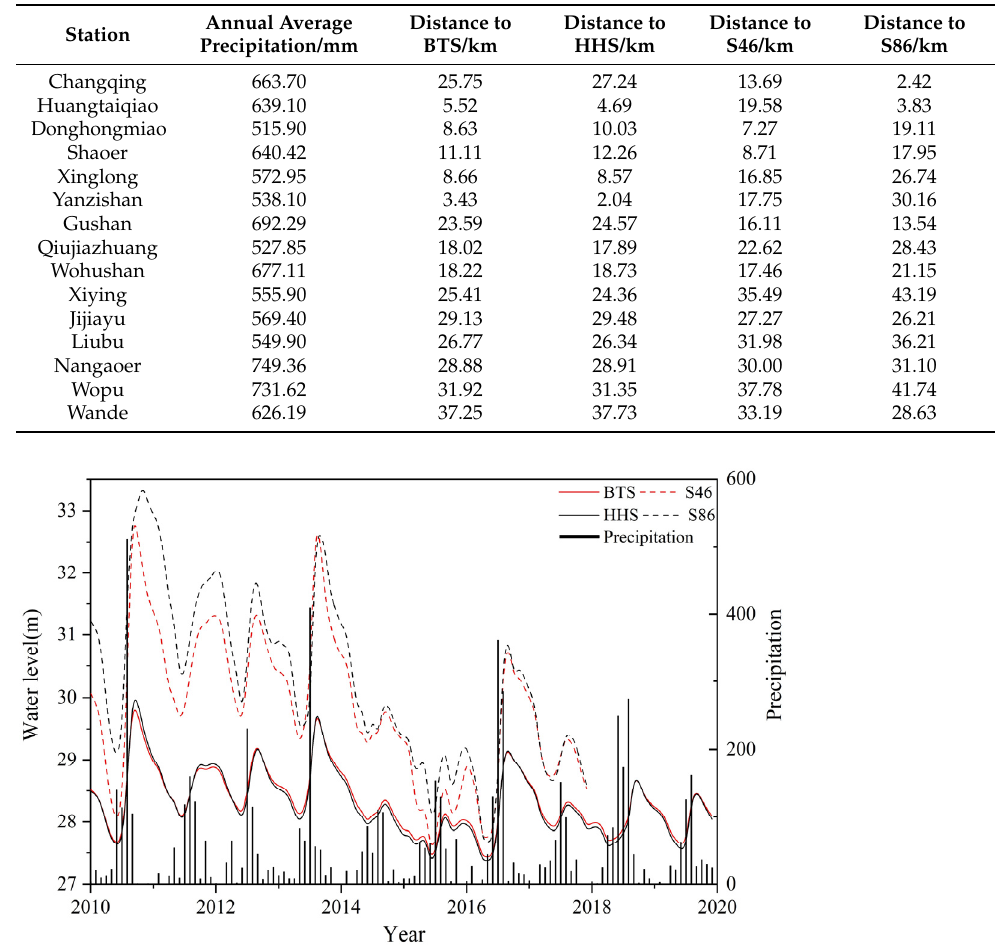
Table 1. Basic information of each precipitation station.